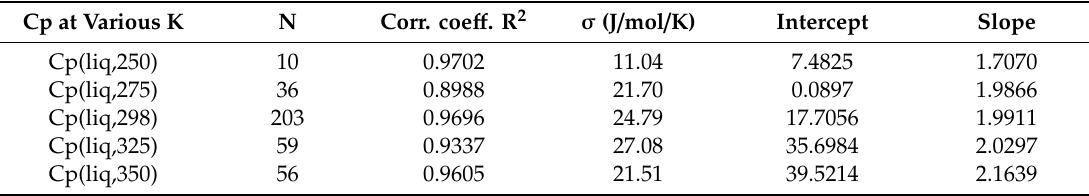
Table 16. Statistics of liquid heat capacities of OH-carrying compounds at various temperatures. Cp at Various K N Corr. coe ff . R